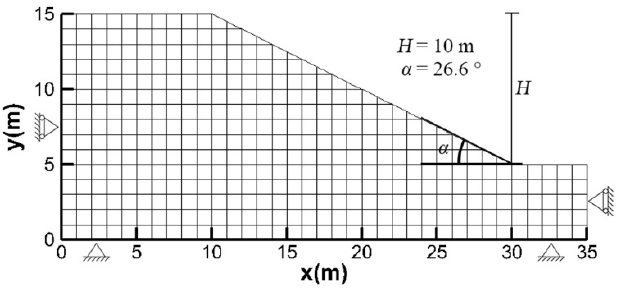
Figure 2. The synthetic slope model. Table 1. Prior statistics of shear strength and other parameters for the numerical model.